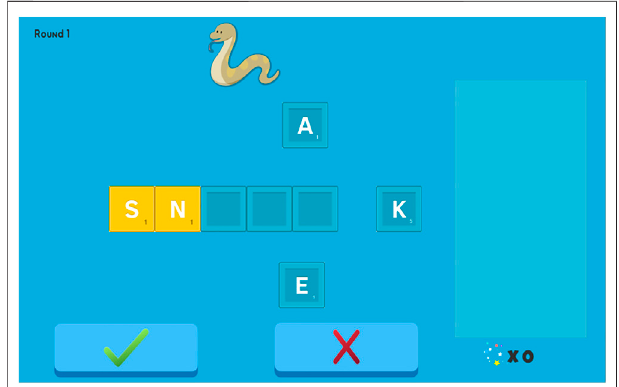
FIGURE 4 | Screencap of a single “ round ” of WordBuilder. “ SNAKE ” is the Target word, and the letters “ S ” and “ N ” have been provided as a partial